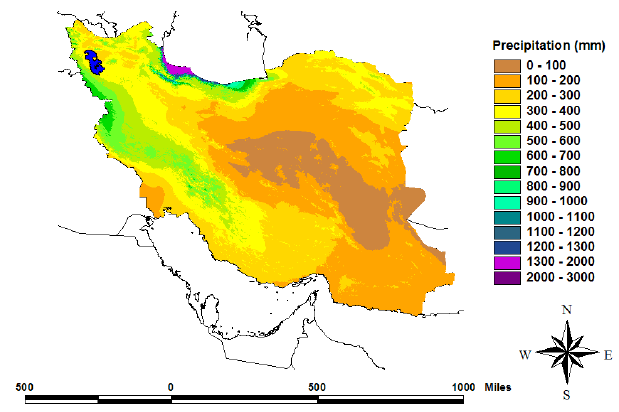
Fig. 2. Mean annual precipitation (mm) across Iran from 1961 to 1990.